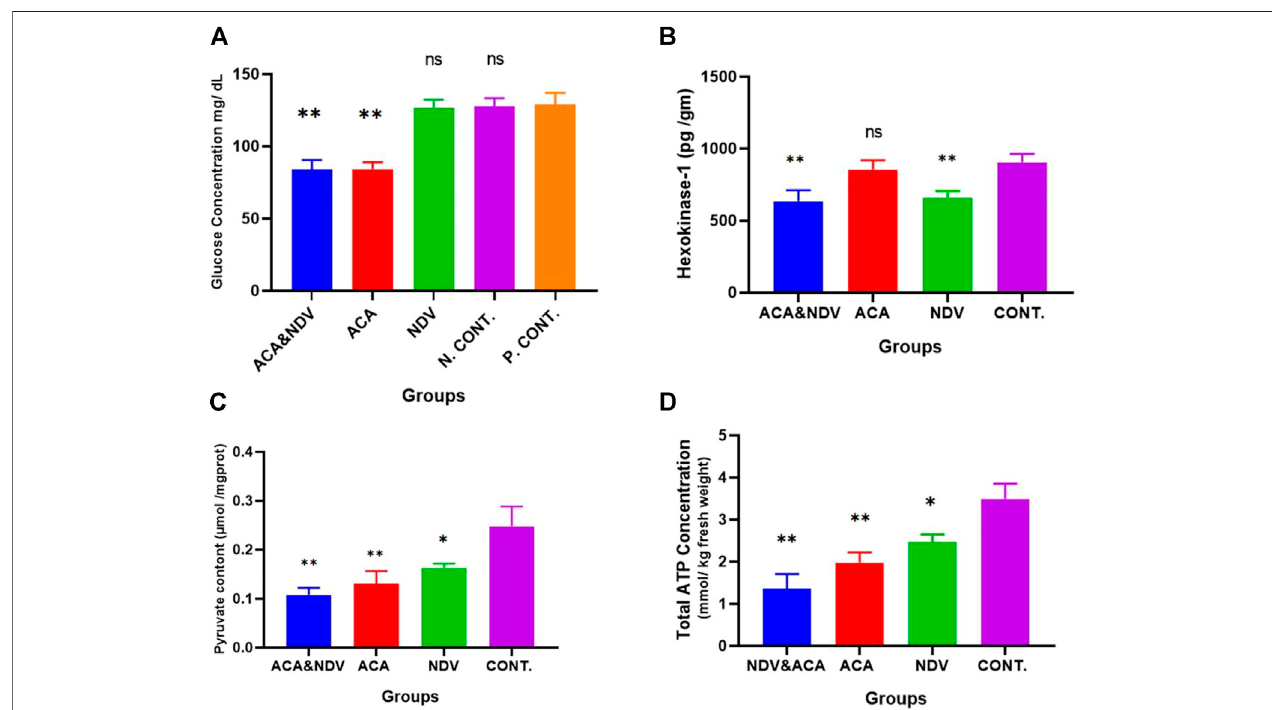
FIGURE 2 | ACA induces glucose deprivation. (A) , Glucose measured after Acarbose (ACA) treatment, Newcastle Disease Virus (NDV), and a combination of AcarboseandNewcastleDiseaseVirus(ACA-NDV),ACA exhibitedasigni fi cant pp p < 0.01decreasedlevelofglucoseinACA andACA-NDVgroupscomparedwiththe positivecontrol(P. CONT)(bearingbreast cancer)and negativecontrolN. CONT. (healthy mice)groups. (B) ELISAassayquanti fi edtheconcentrationoftheHexokinase enzyme. We observed a signi fi cant decrease in the expression of the HK-1 protein in the NDV- and ACA-NDV-treated group compared to the untreated control group. ACA alone had no signi fi cantimpact on HK-1 concentration. (C) Measurement ofpyruvate content. (D) Measurementoftotal ATPconcentration. In combination withNDV,ACAef fi cientlyinhibitsglycolysisproduct(pyruvate)andATP.Tocon fi rmtheeffectofACAandNDVcombinationtherapyonglycolysisproducts,weexamined pyruvate and total ATP level in tumor tissue. We found that the ACA-NDV treatment had signi fi cantly reduced glycolysis product (pyruvate) and ATP compared to the untreated group. ppp p < 0.01, pp p < 0.01, and p p < 0.05 versus